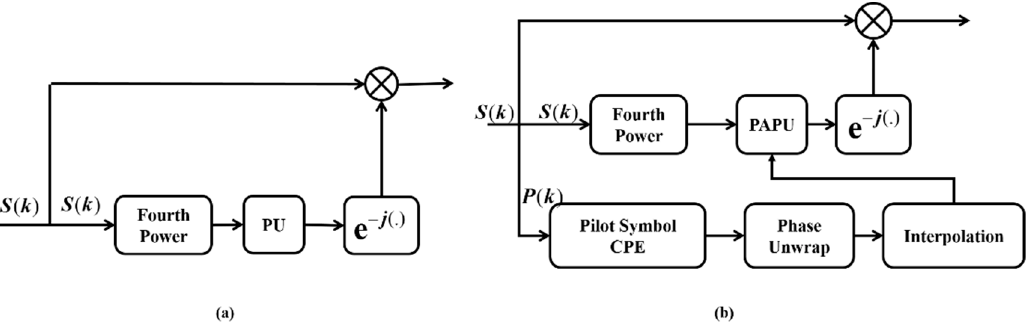
Figure 2. Fourth-power carrier phase recovery with ( a ) usual-phase unwrap, ( b ) pilot-symbol-aided phase unwrap.